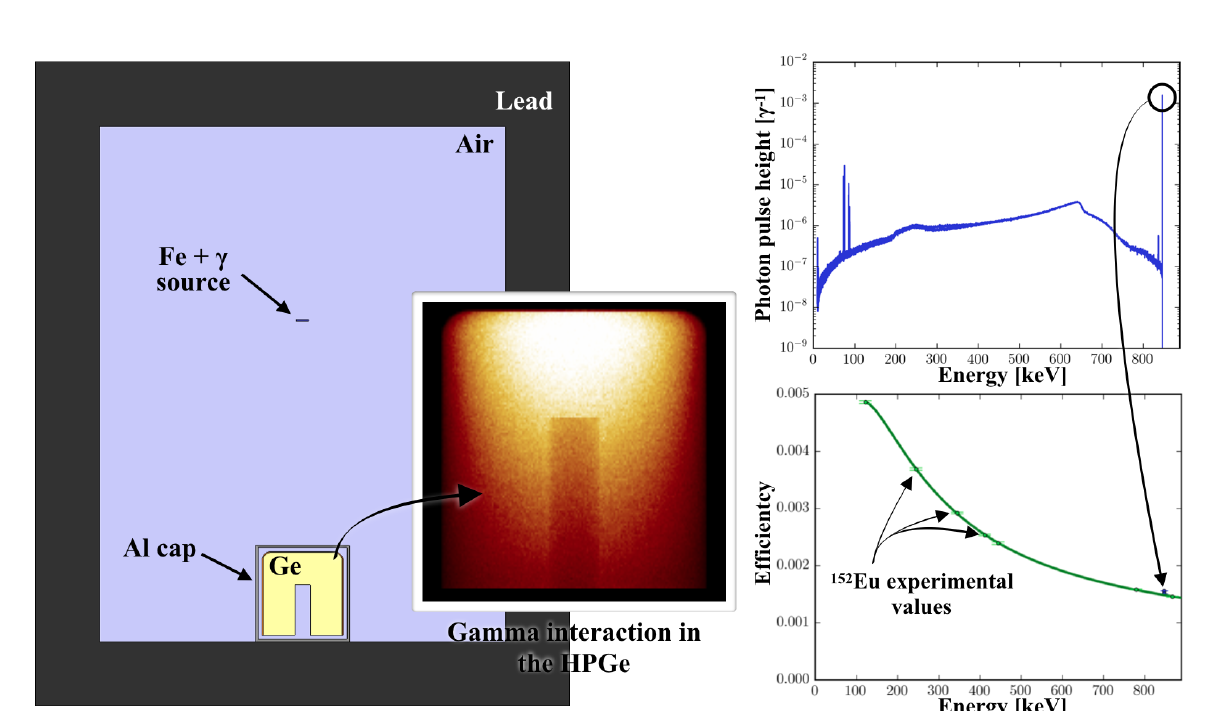
Figure 5: HPGe modelization in Serpent2: geometry and gamma interaction in the cristal (left), photon pulse height detector (top-right), and the corresponding efficiency (bottom-right) with the experimental values in green for the